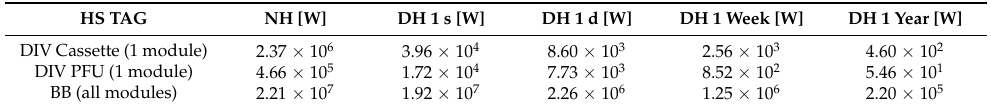
Figure 7. Overview of divertor in-VV volumes system nodalization: detailed volumes for PFU and cassette, related heat structures and related coupling. Control Volumes (CV) are shown as blue shaded boxes, Heat Structures (HS) are shown as white boxes, red arrows show heat transfer mechanisms modeled across HS (FUN1 functions) or radiative towards plasma chamber. Table 2. Data exploited for modeling nuclear heating (NH) power (occurring during the plasma pulse) and decay heat (DH) power (occurring after plasma